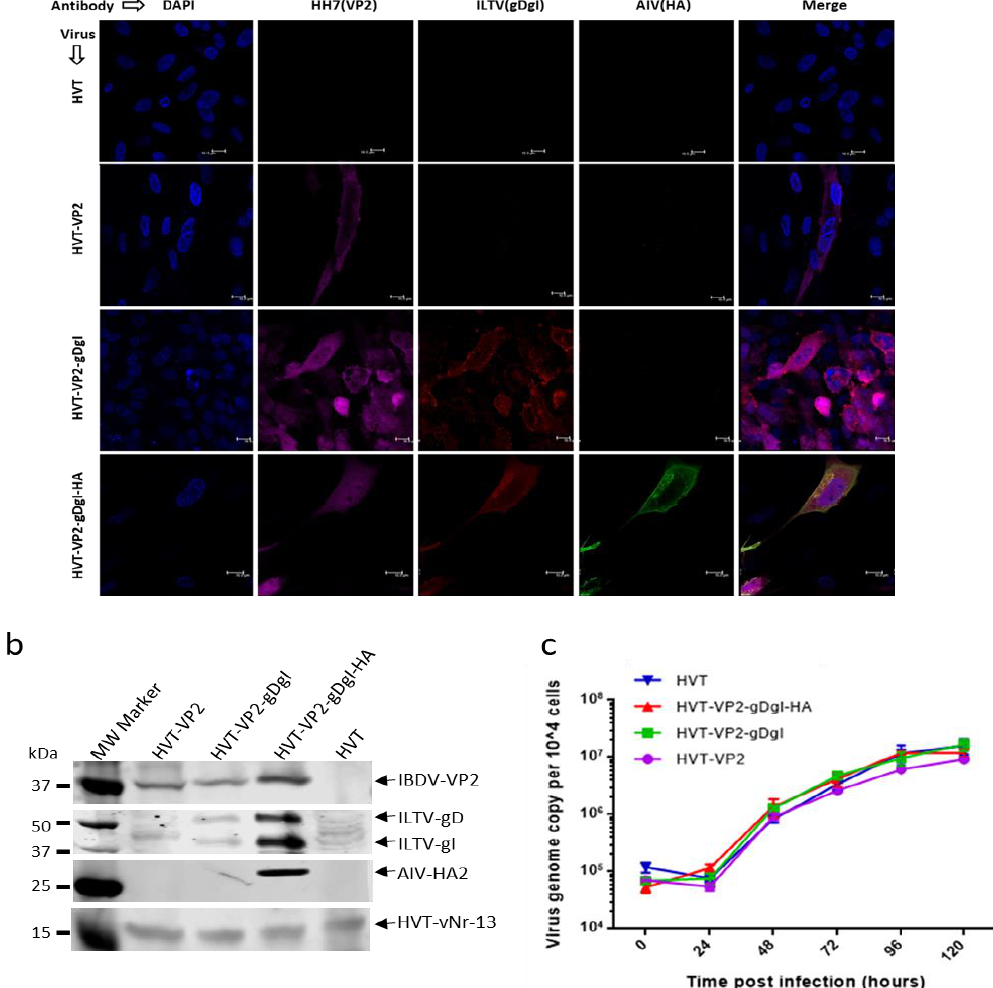
Figure 2. Characterization of the recombinant HVT viruses. ( a ) Detection of VP2, glycoprotein D-glycoprotein I (gDgI), and HA expression from the recombinant viruses in CEFs with IFA. VP2 expression was detected with MAb HH7 followed by goat anti-mouse IgG labelled with Alexa Fluor 633 (Far red). gDgI expression was detected with anti-ILTV chicken serum followed by goat anti-chicken IgG labelled with Alexa Fluor 568 (red). HA expression was detected with anti-H9N2 chicken serum followed by goat anti-chicken IgG labelled with Alexa Fluor 488 (green). The nuclei were stained with DAPI (blue). ( b ) Detection of VP2, gDgI and HA expression in recombinant virus infected CEF by Western blotting with the same primary antibodies described in (A). HVT-encoded Bcl-2 homolog vNr-13 was used to confirm HVT infection. ( c ) The growth kinetics of recombinant HVT viruses. In vitro growth rates of HVT-WT, HVT-VP2, HVT-VP2-gDgI and HVT-VP2-gDgI-HA measured from the viral genome copy numbers determined using TaqMan real-time qPCR on DNA extracted from chick embryo fibroblasts (CEF) harvested at various time points after inoculation. Viral genome copy numbers per 10,000 cells (shown with 95% confidence intervals) are shown on the y axis.